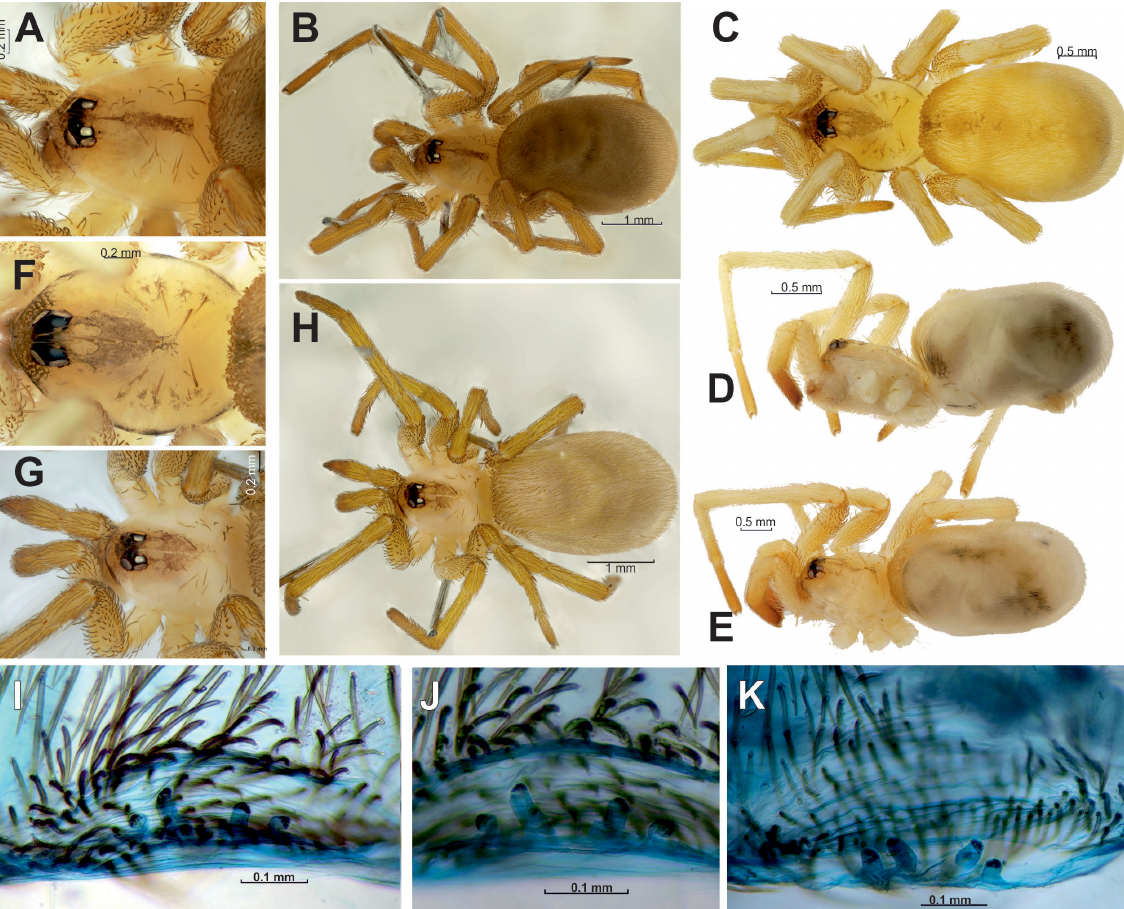
Fig. 29. Somatic characters and endogyne of Zaitunia beshkentica (Andreeva & Tyshchenko, 1969), ♀♀ from Chiluchor-Chashma ( A–B ), Babatagh ( C – F ) and Khurshedi ( G – K ). — A , F–G . Prosoma, dorsal. B–C , H . Habitus, dorsal. D–E . Same, lateral and dorso-lateral. I – K . endogyne,